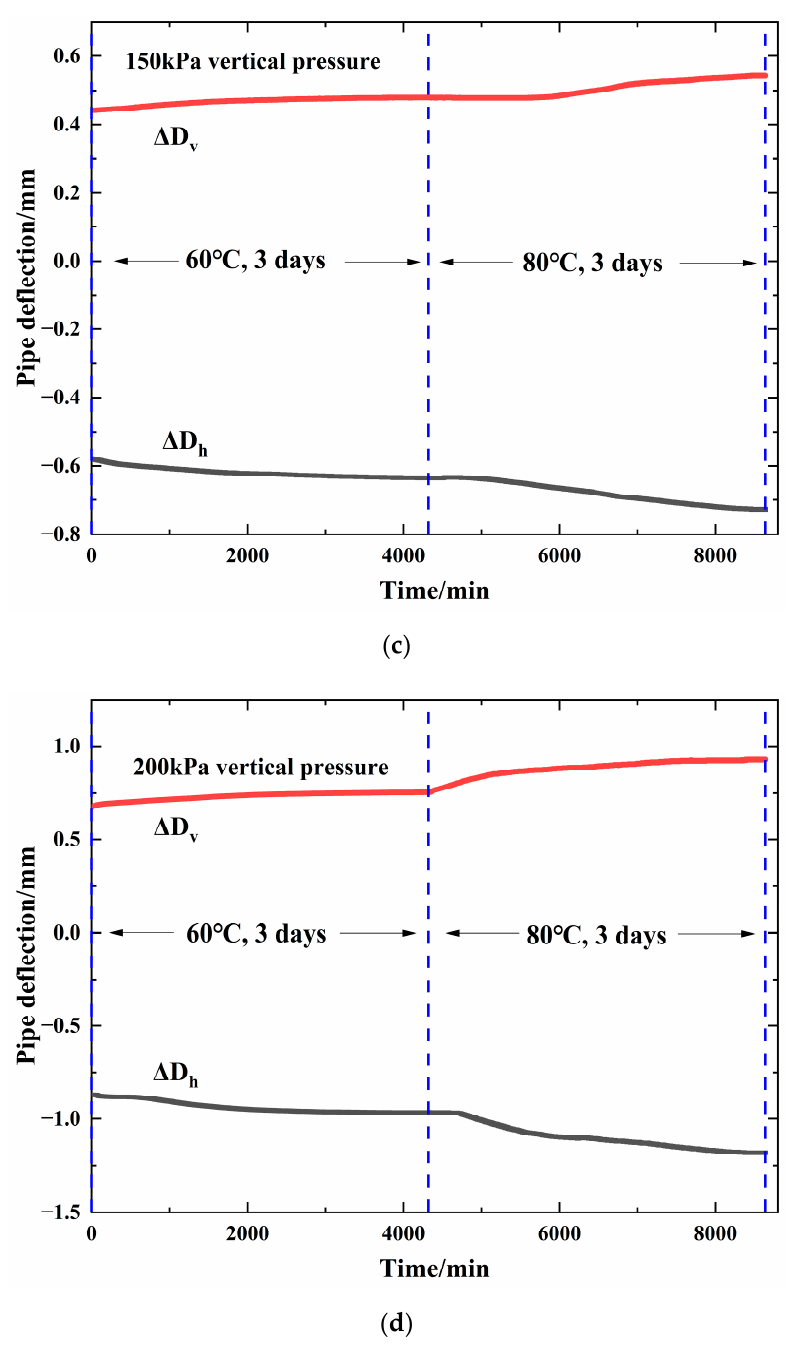
Figure 5. The creep measurements of the HDPE pipe in the duration of the test: ( a ) 50 kPa vertical pressure; ( b ) 100 kPa vertical pressure; ( c ) 150 kPa vertical pressure; ( d ) 200 kPa vertical pressure.